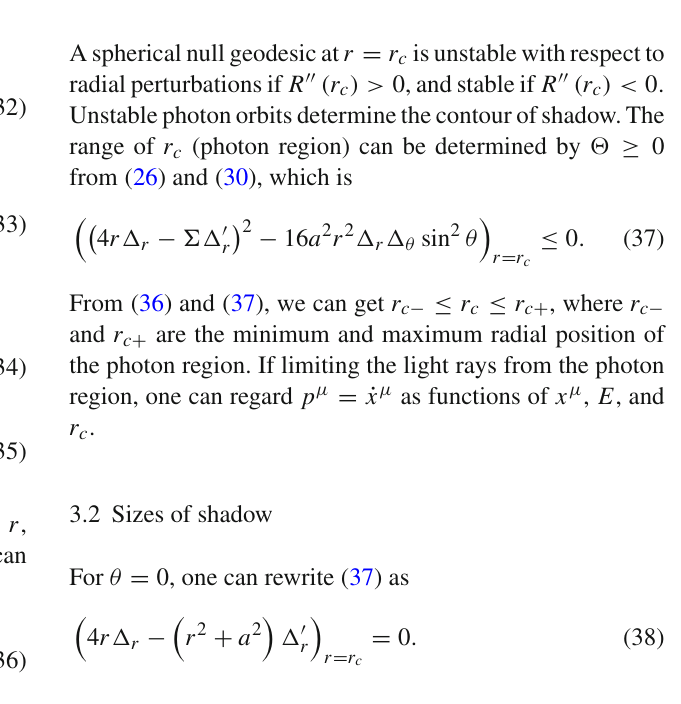
mological constants. b Shadows and distortion parameters of rotating Hayward–de Sitter black holes of selecteddifferent magnetic monopole charges. c Shadows and distortion parameters of rotating Hayward–de Sitter black holes of selected different the spin parameters